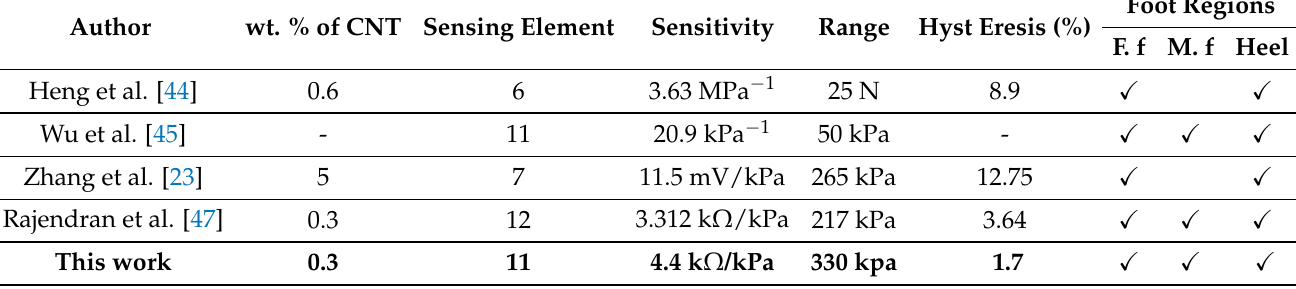
Table 1. Comparison of proposed in-sole sensor with previous works based on CNT/PDMS pressure sensor for foot pressure